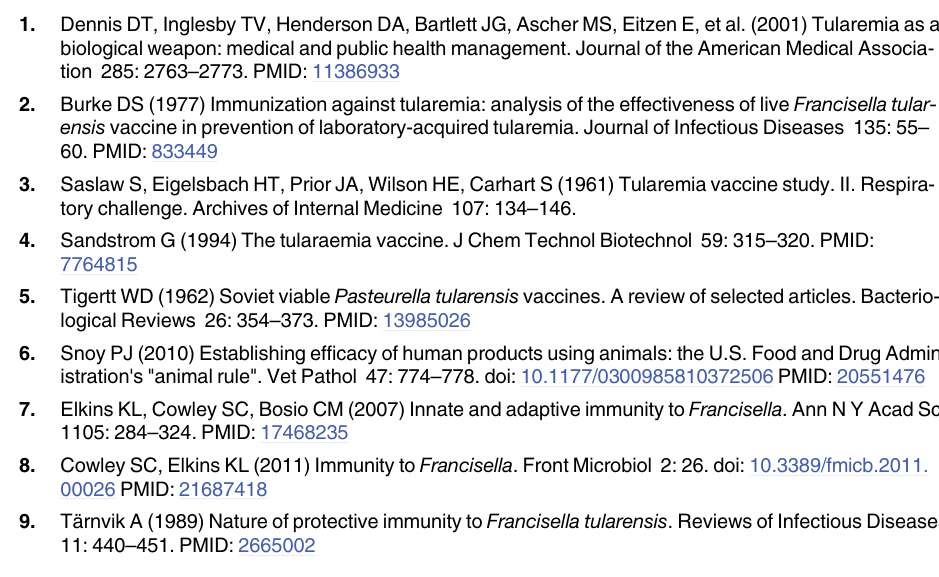
S3 Table. Anti-LVS total IgG titers of vaccinated mice. Pooled sera from five mice for each vaccine group were obtained at the indicated time points and analyzed for anti-LVS total IgG. Those experiments were repeated four times in both BALB/cByJ and C57BL/6J mice. Shown are medians and ranges of antibody titers obtained using data from the four replicate experiments. S4 Table. Anti-LVS IgM and IgG isotypes titers of vaccinated mice. Pooled sera from five mice for each vaccine group were obtained at the indicated time points and analyzed for anti- LVS total IgM and anti-LVS IgG isotypes. Shown are antibody titers obtained from two repli- cate experiments. (cid:1) Titers for sera obtained from BALB/cByJ mice. # Titers for sera obtained from C57BL/6J